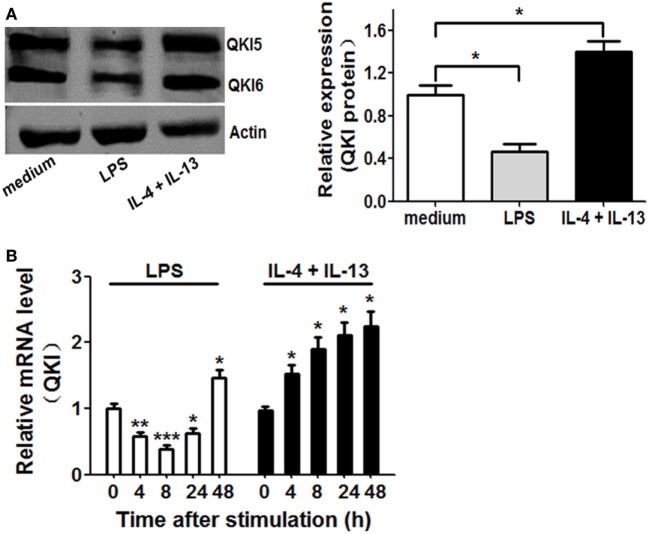
Expression of quaking (QKI) in differently polarized macrophages. (A) Peritoneal macrophages from wild-type (WT) mice were stimulated with 1 µg/ml lipopolysaccharide (LPS) or IL-4 (20 ng/ml) plus IL-13 (20 ng/ml) for 16 h. Total cell lysates were subjected to western blot to analyze the protein expression of QKI, with actin as an internal control. One representative immunoblot is shown (on the left). Graphs (on the right) are representative quantification of the band intensity for immunoblots from three independent experiments. (B) Real-time PCR analysis of QKI mRNA in mouse macrophage RAW 264.7 cells left untreated or stimulated for 4, 8, 24, or 48 h with 1 µg/ml LPS or IL-4 (20 ng/ml) plus IL-13 (20 ng/ml). Results presented relative to those of untreated macrophages, set as 1. Actin served as an internal control. All bars represent the mean of measurements from three independent experiments, and the error bars indicate ±SEM. *p < 0.05, **p < 0.01, ***p < 0.001.